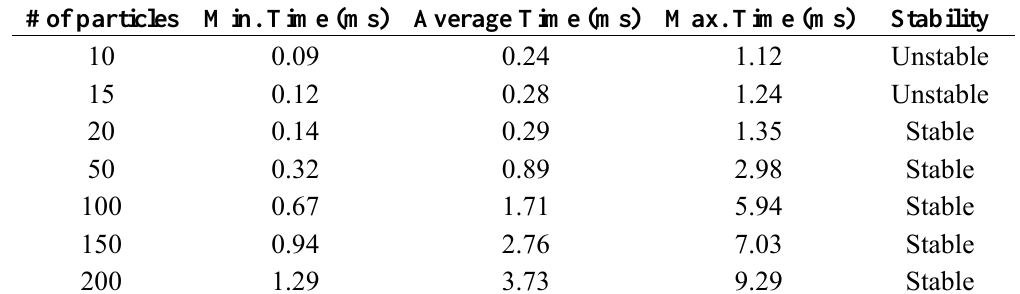
Table 1. Table of execution times obtained by varying the number of particles used in the filter. # of particles